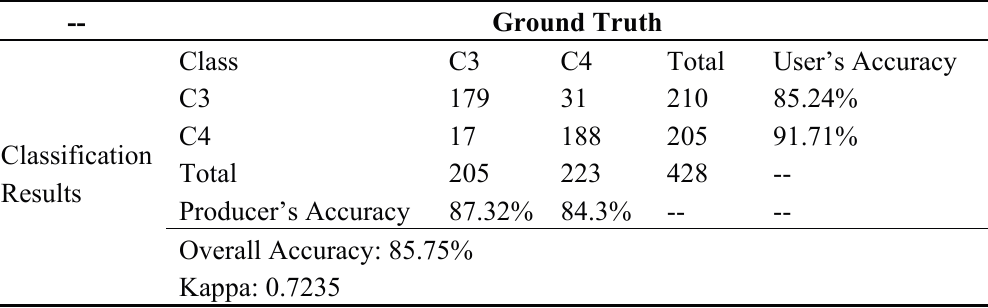
Table 7. C3 and C4 classification accuracy of blended time-series